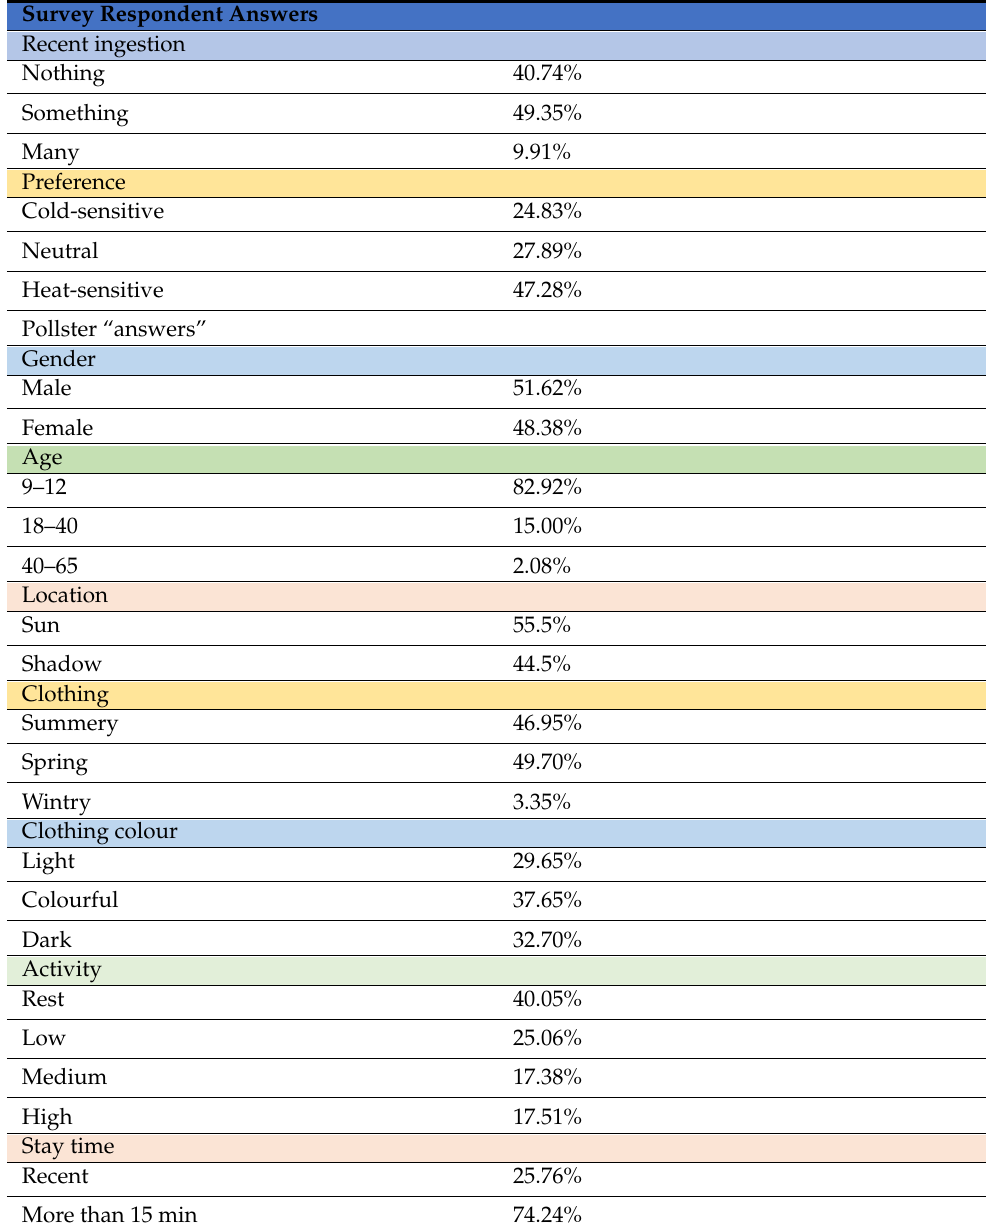
Table 6. Average values of survey